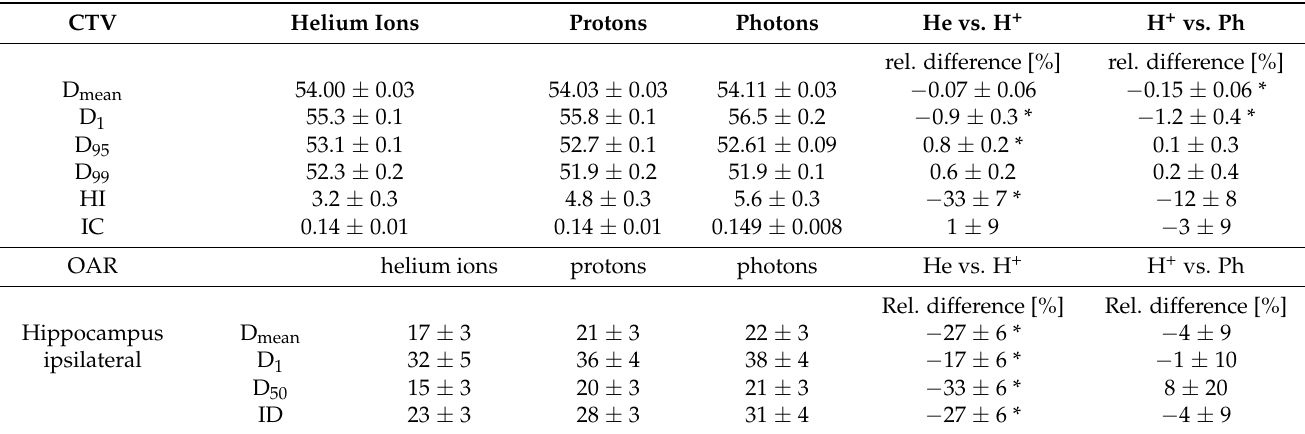
Table 2. Dose comparison target volume and